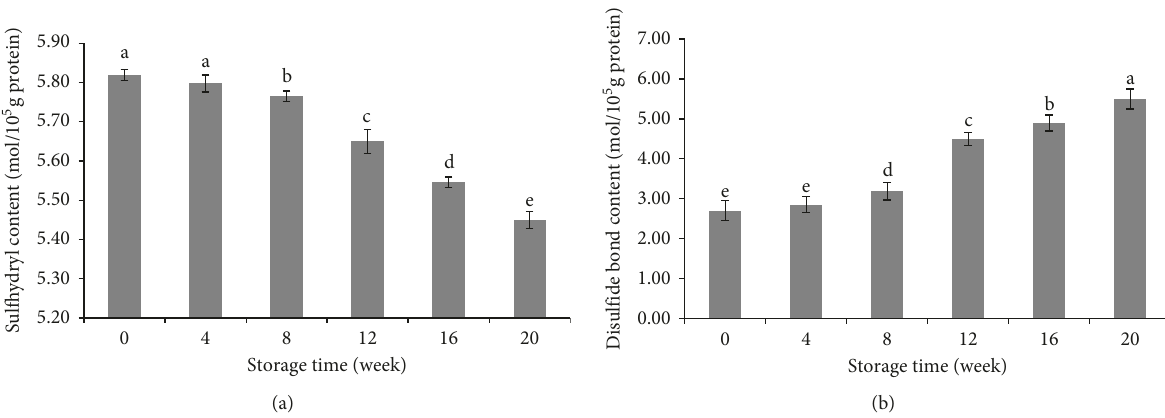
Figure 4: Changes in sulfhydryl (a) and disulfide bond (b) contents of NAM extracted from the Basa fish fillet during frozen storage at − 20 ° C for 20 weeks. Bars represent standard deviation from triplicate determinations. The different letters on the bars indicate significant differences ( p < 0 . 05).